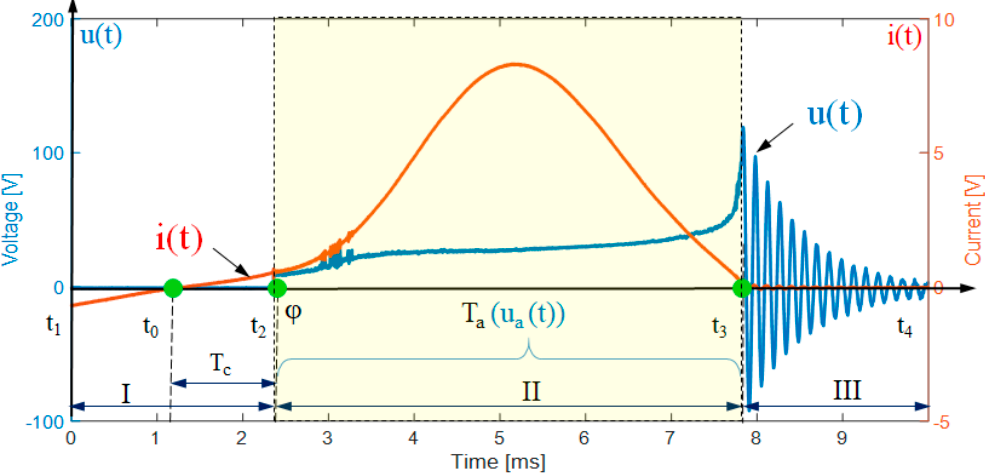
Figure 4. Exemplary recorded waveforms of load current and voltage across the contacts registered during CI-1 contact breaking for the A1 supply voltage signal.